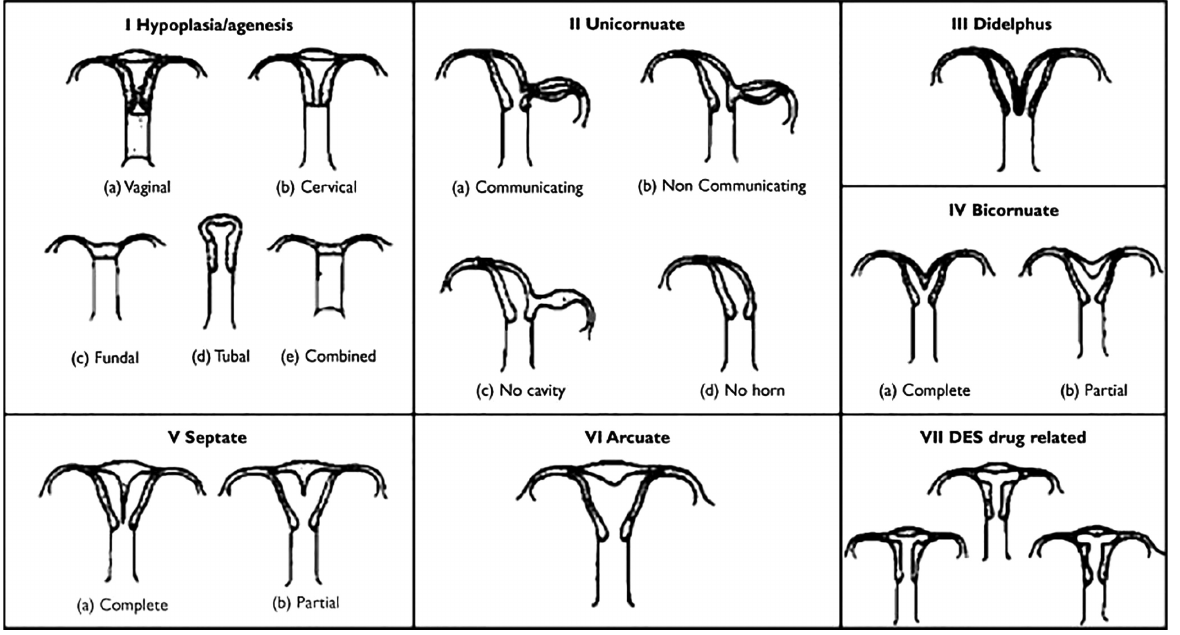
Figure 2 . Mullerian anomalies classi fi cation by the AFS 1988